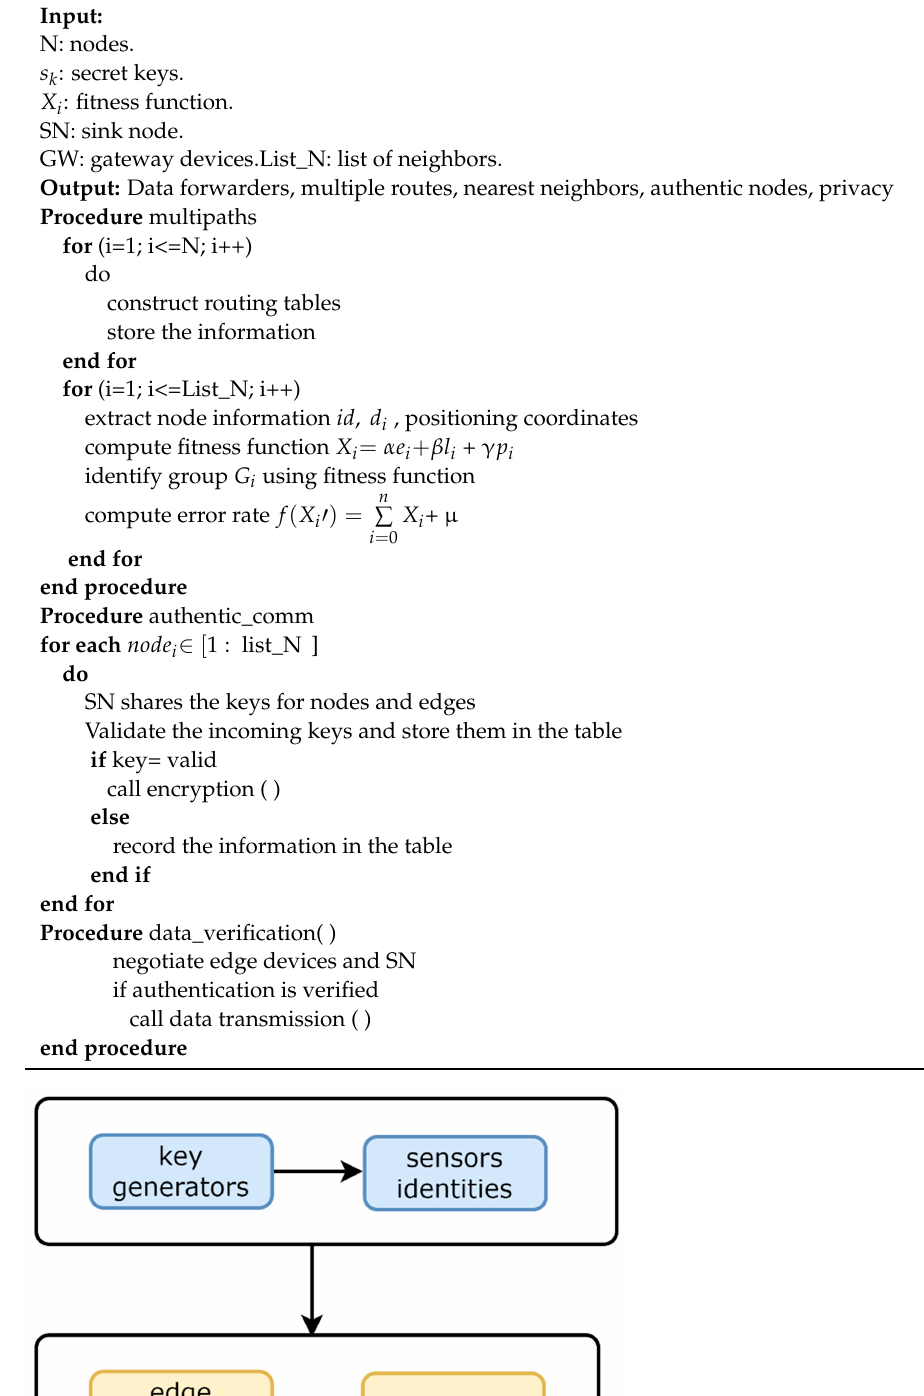
Algorithm 1: Secure edge-based energy management protocol